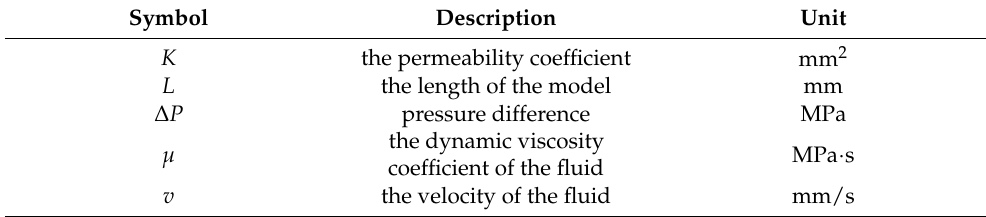
Table 2. Parameters for calculating the